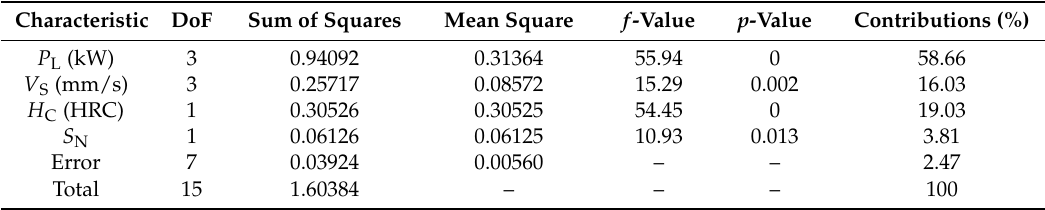
Table 3. ANOVA results for factors including S N